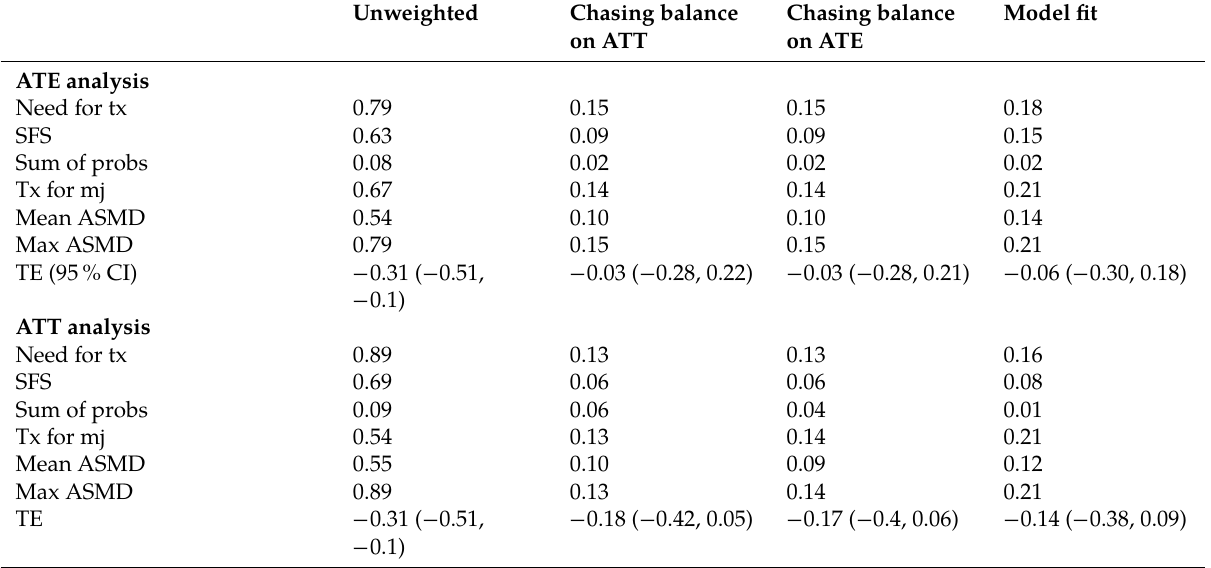
Table 3: ASMD for each pretreatment covariate and summary statistics across covariates as well as treatment effect estimates (standardized) for ATE and ATT analyses for each candidate approach to select optimal iteration of GBM for PA versus non-PA example Unweighted Chasing balance Chasing balance Model fit on ATT on ATE ATE